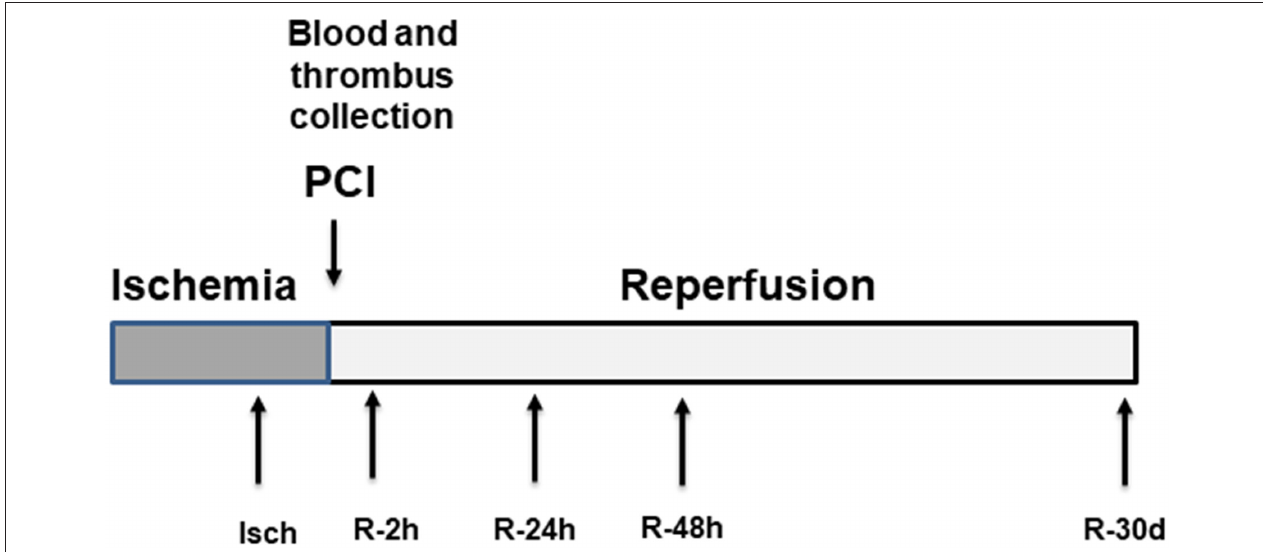
FIGURE 1 | Overall study design. Plasma samples were collected at five different time points including the time of arrival at the cardiac catheterization laboratory for primary PCI (Isch), 2h post angioplasty (R-2h), 24h post angioplasty (R-24h), 48h post angioplasty (R-48h) and 30-day post-PPCI (R-30